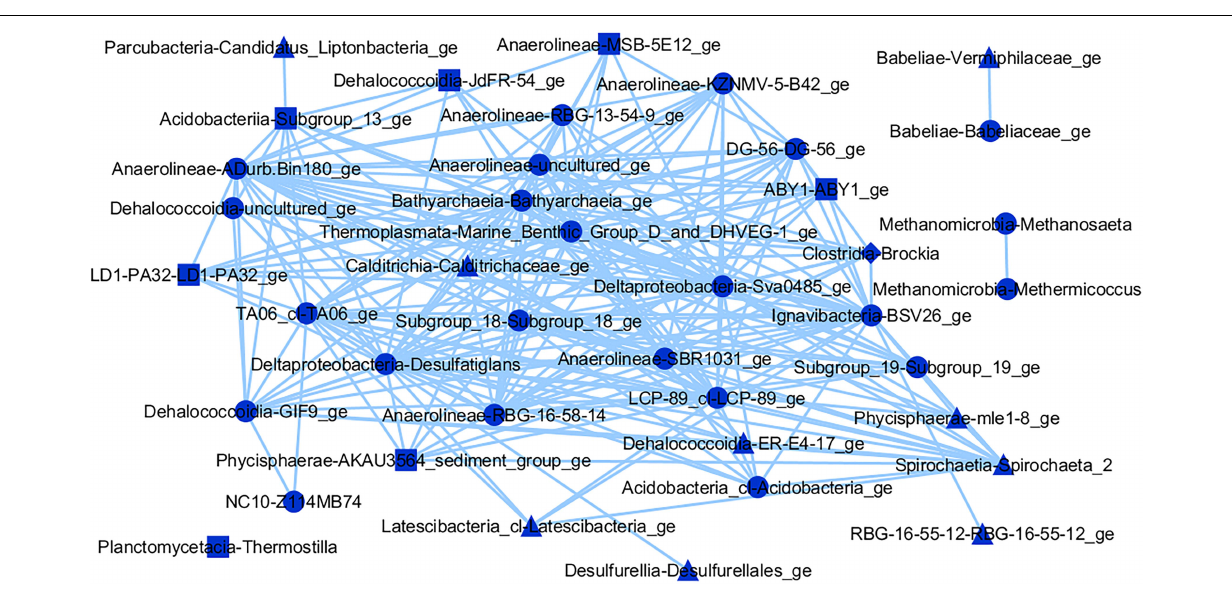
FIGURE 8 | Interaction network of microbial genera in the blue module (threshold = 0.15), which presented positive correlation ( p ≤ 0.05) with CH 4 (triangles), CO 2 (squares), or both gases